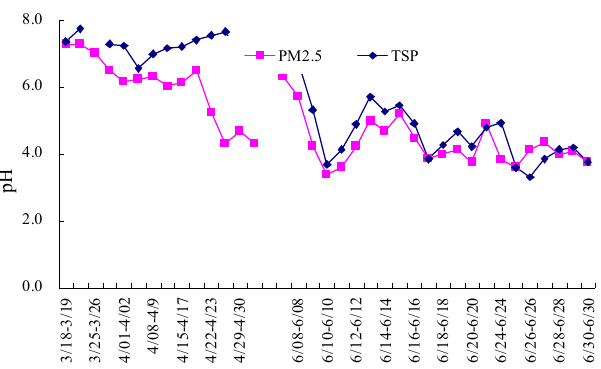
Fig. 4. Daily variations of pH of aqueous filtrates of aerosols at MT, 2006.